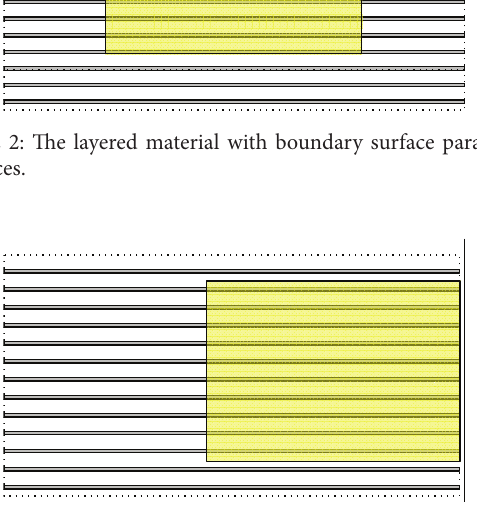
Figure 3: The layered material with boundary surface placed perpendicularly to